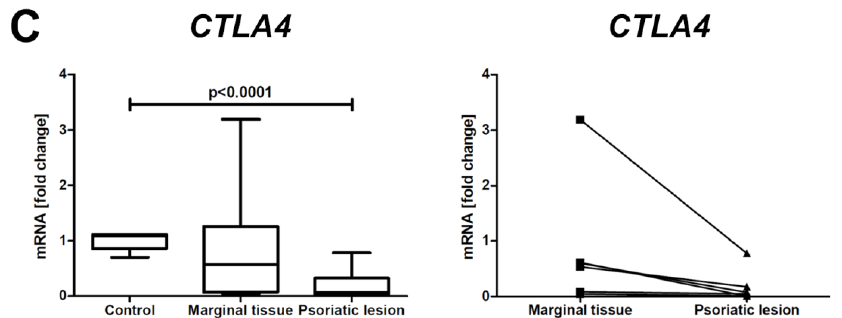
Figure 2. mRNA expression of anti-inflammatory genes ( FOXP3 , IL2 , and CTLA4 ) in healthy skin, marginal tissue, and PsO lesions. The graphs on the left compare the expression levels of FOXP3 ( A ), IL2 ( B ), and CTLA4 ( C ) in PsO lesions and their marginal tissue (n = 6) with skin of healthy individuals (n = 6). The graphs on the right show the paired gene expressions of FOXP3 ( A ), IL2 ( B ), and CTLA4 ( C ) in PsO skin lesions and marginal tissue from each individual patient (n = 6).